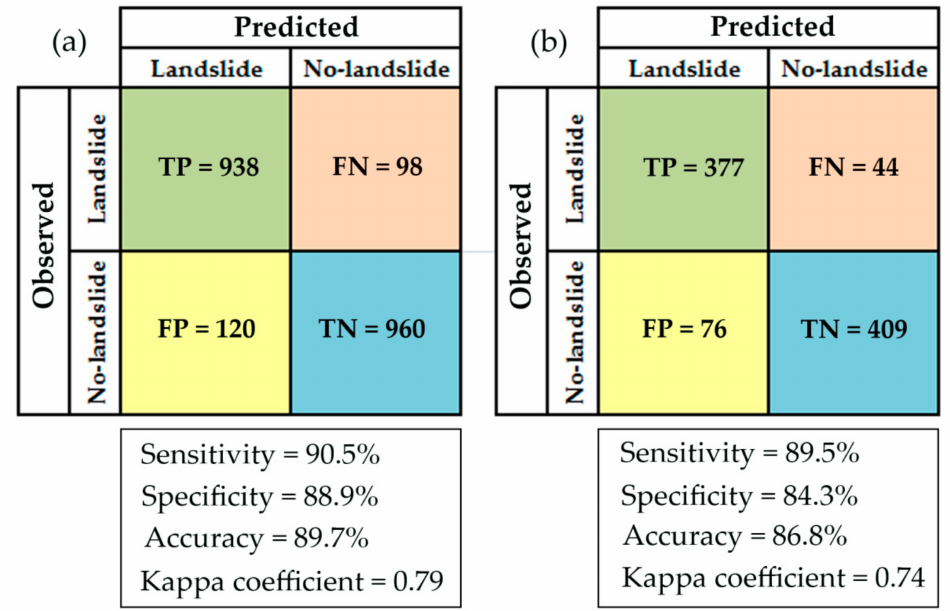
Figure 8. Confusion matrix and statistical indexes analysis of shallow landslide susceptibility model using training dataset ( a ) and validation dataset ( b ) TP = true positives, TN = true negatives, FP = false positives, and FN = false negatives for training and validation